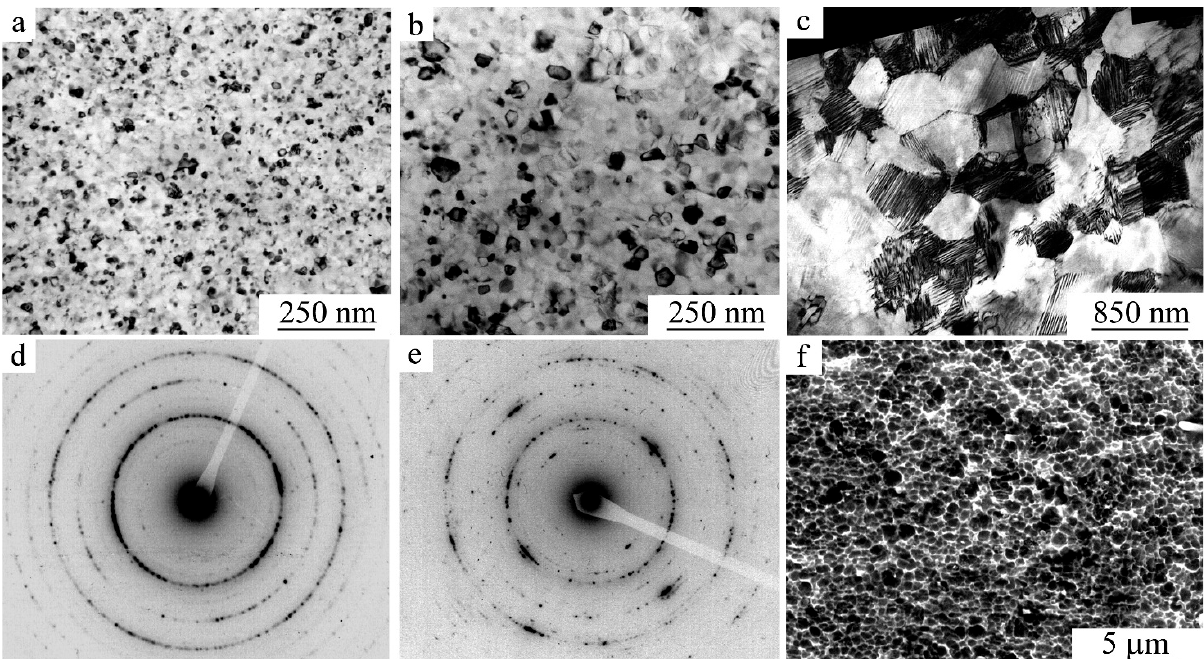
Figure 14. ( a – c ) Bright-field TEM images of the microstructure, and ( d , e ) the corresponding SAED patterns (SD 0.3 µm), of the HPT-preliminarily treated Ti 49.4 Ni 50.6 alloy after PDHT at ( a , d ) 673, ( b , e ) 773, and ( c ) 823K for 1 h; ( f ) SEM image of the microstructure after HPT and PDHT at 823 K for 1 h [75].